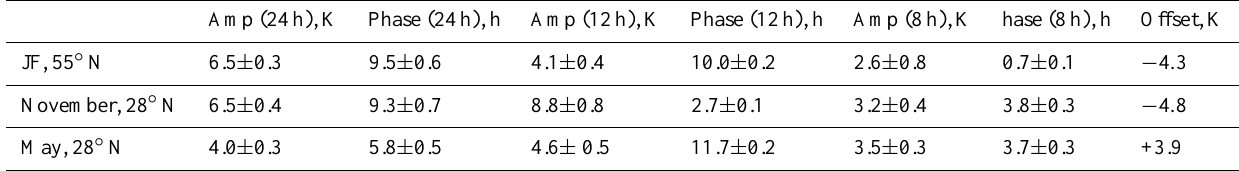
Table 4. Tidal parameters at 89km height – self consistent